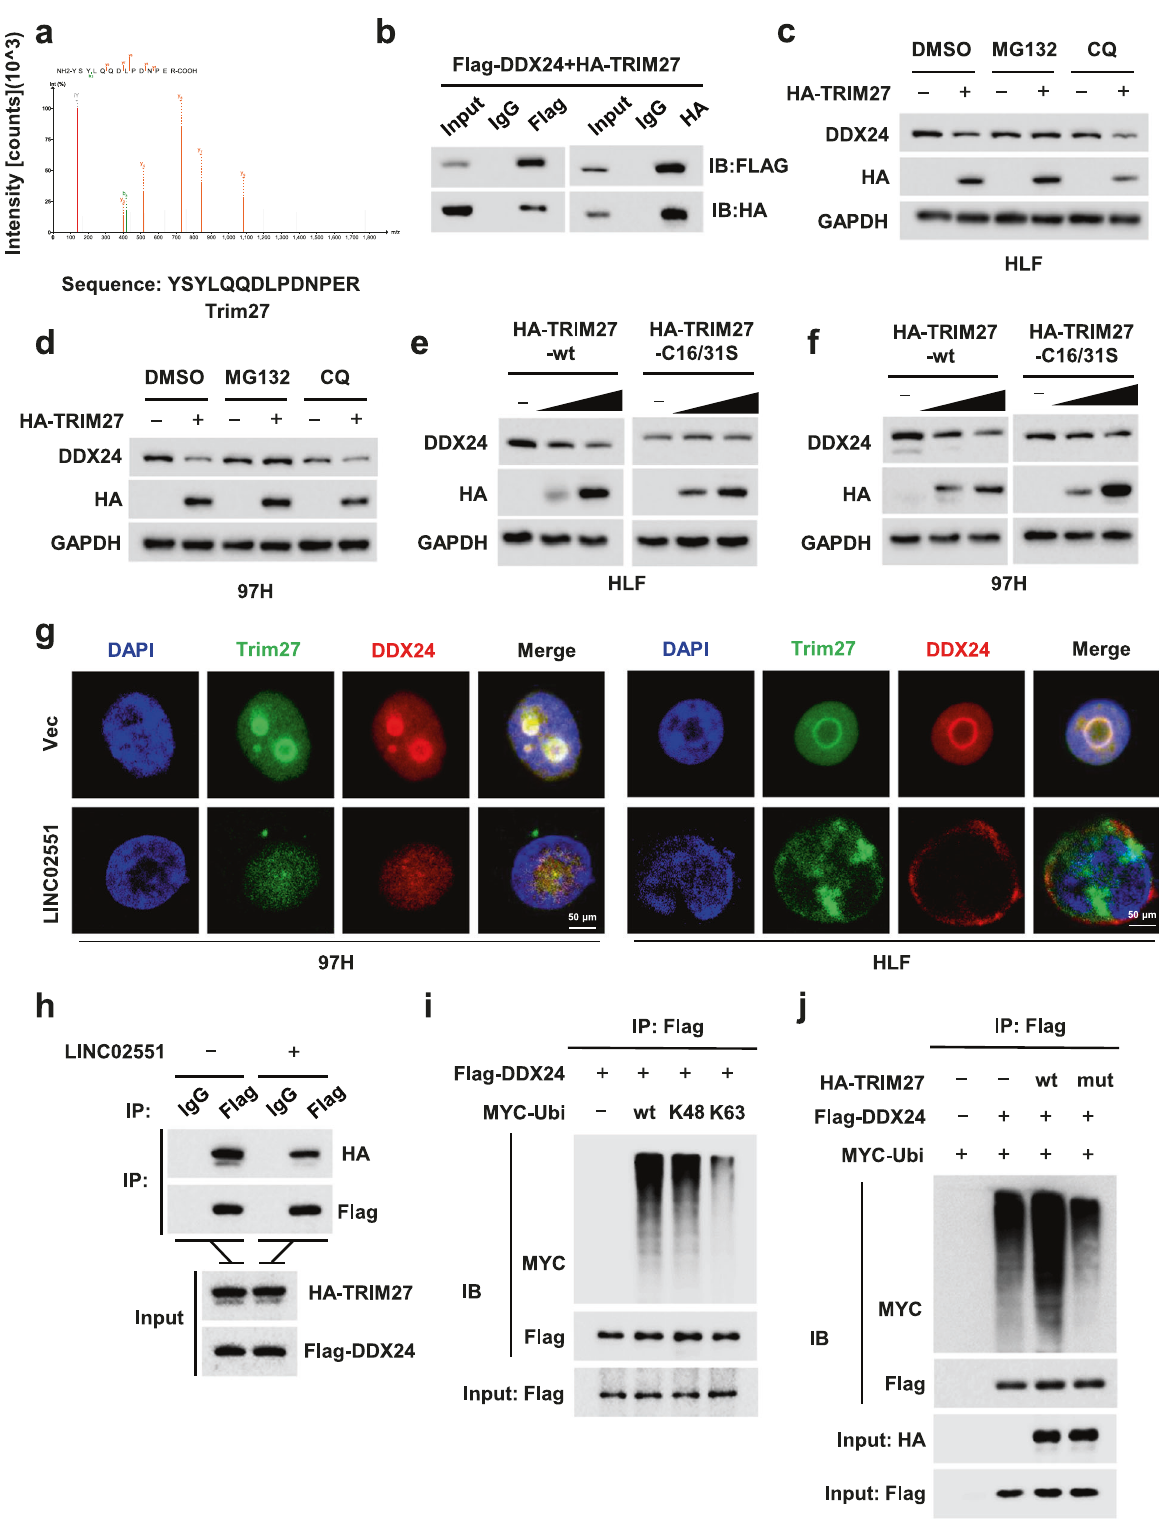
Fig. 5 TRIM27 is a E3 ligase that mediates the ubiquitination-induced degradation of DDX24 in HCC. a Representative peptide sequences of TRIM27. b Co-IP results showing the combination of DDX24 and TRIM27 in 293 T cells. c , d HLF and 97H cells were treated with DMSO, MG132 or CQ for 4 h and endogenous DDX24 was measured by WB. e , f DDX24 expression was measured through WB in HLF and 97H cells transfected with TRIM27-wt or TRIM27-mut. g IF results of TRIM27 and DDX24 with or without LINC02551 overexpression. h Co-IP results of TRIM27 and DDX24 with or without LINC02551 overexpression. i IP results showing the combination of DDX24 and ubiquitin (wt, K48 and K63). j IP results showing the combination of DDX24 and ubiquitin when in cells transfected with TRIM27-wt or TRIM27-mut.